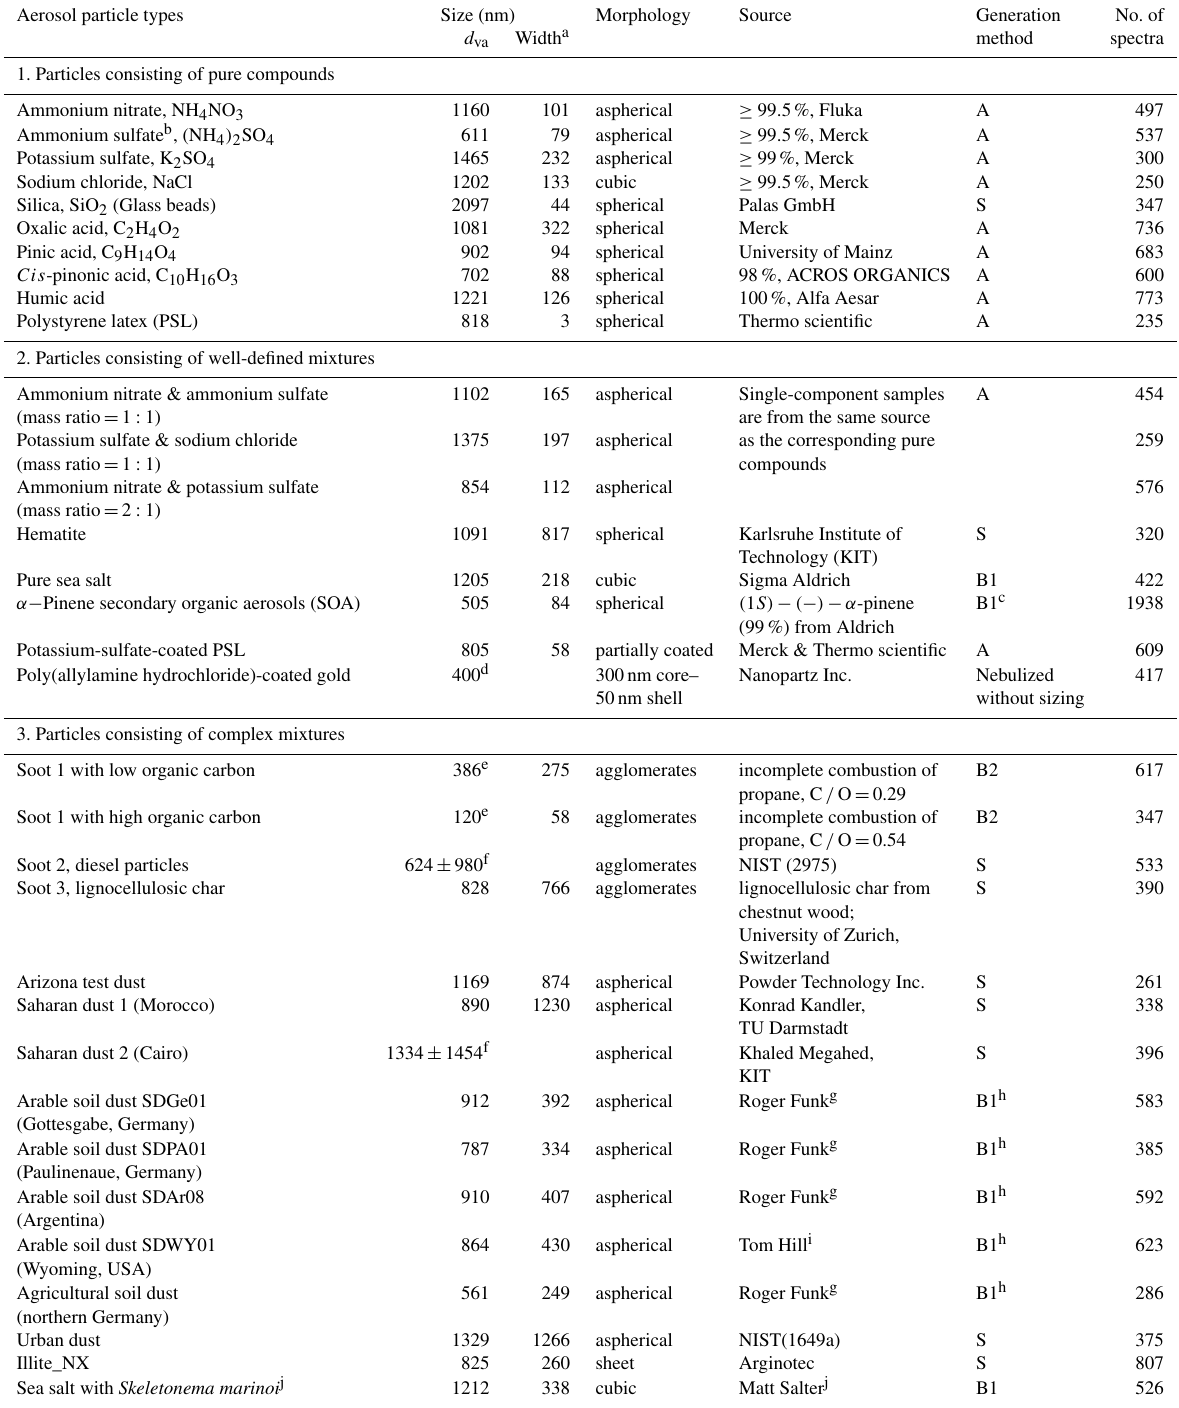
Table 1. Overview of laboratory-generated aerosol particles for reference mass